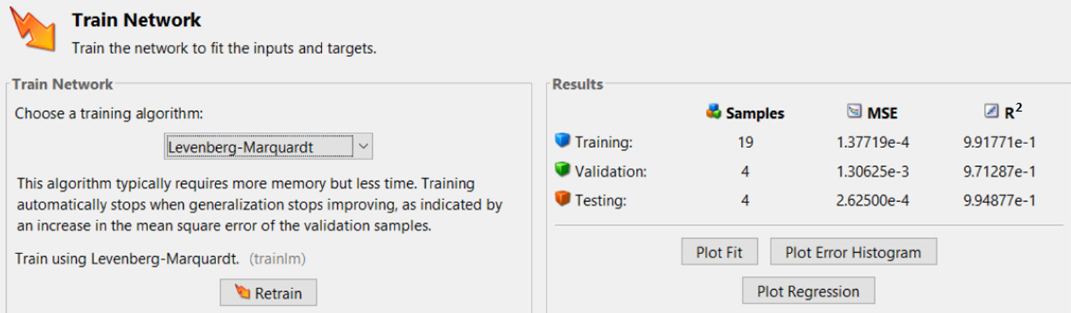
Figure 4. The training process results .